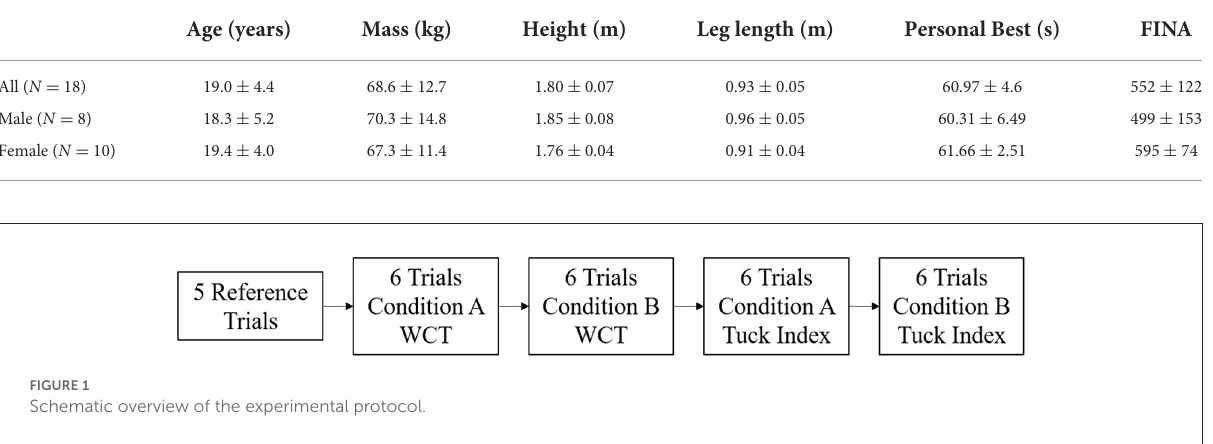
TABLE 1 Mean ± standard deviation of the participant’s age, mass, height, leg length, and performance level.